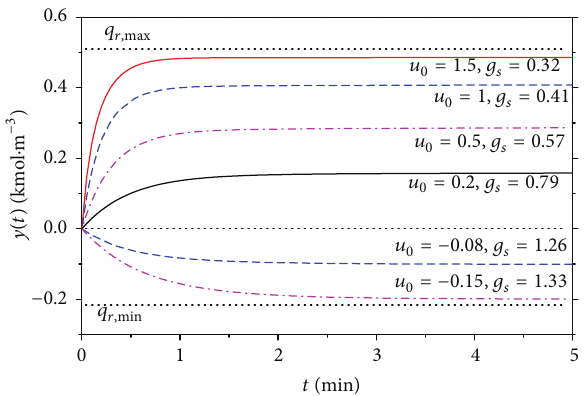
Figure 9: Results of dynamic analyses for the changes of input 𝑢 0